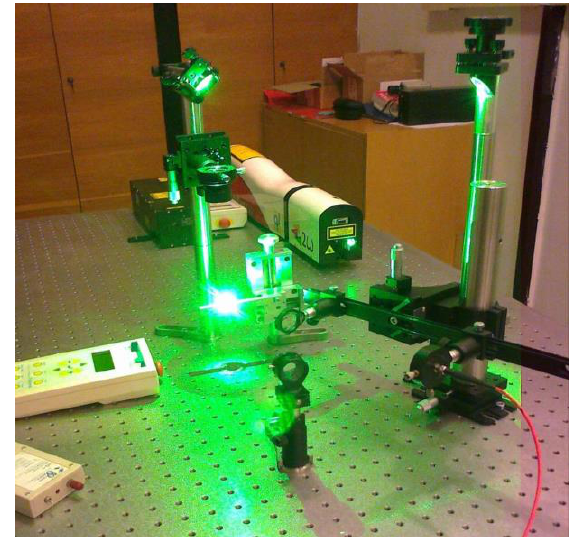
Figure 1. Laser spark created above the sample surface.